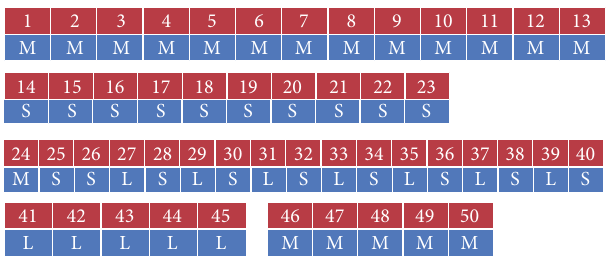
Figure 11: The Gridmix job has 50 jobs in total. The first 13 jobs are medium size. The jobs from 14 to 23 are small. The small job and large job are alternate arrived from job 26 to job 40. The large jobs appear consecutive form job 41 to job 45 and the last 5 jobs are medium.